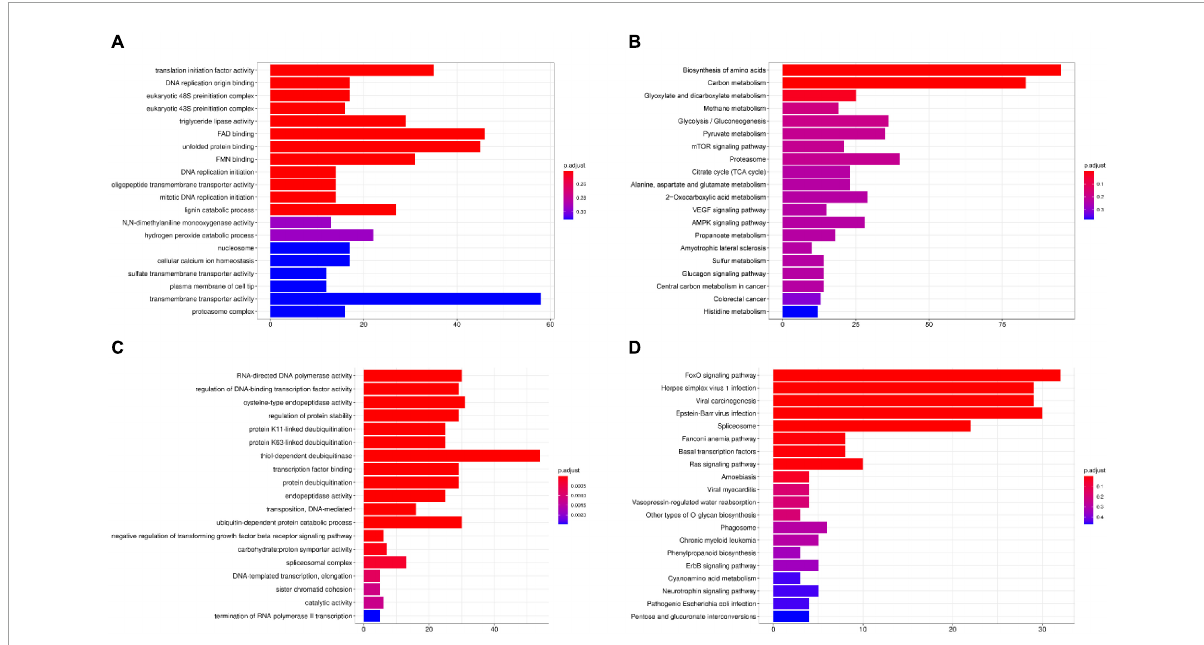
FIGURE12 Gene family enrichment analysis of I. hispidus compared with S. baumii, P. nigrolimitatus and P. pouzarii . (A) GO enrichment results of the share gene family. (B) KEGG enrichment results of the shared gene family. (C) GO enrichment results of the unique gene family. (D) KEGG enrichment results of the unique gene